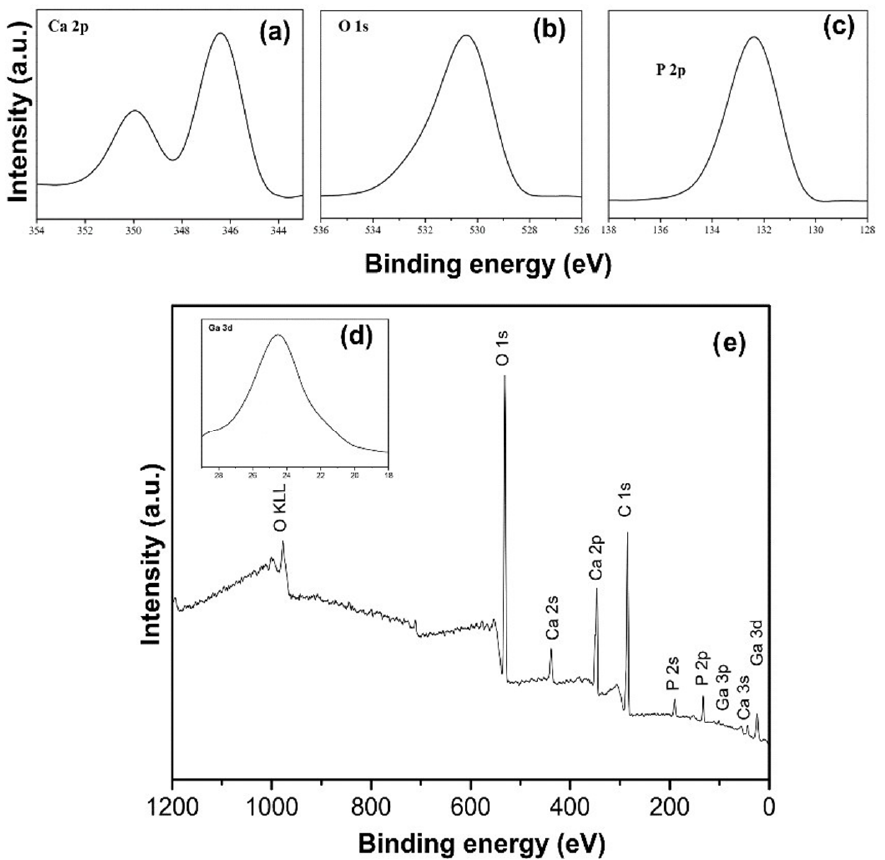
Figure 2. XPS spectra of Ga-HAp showing the devolution of biding energies of ( a ) calcium, ( b ) oxygen, ( c ) phosphorous, ( d ) gallium, and ( e ) XPS spectrum of